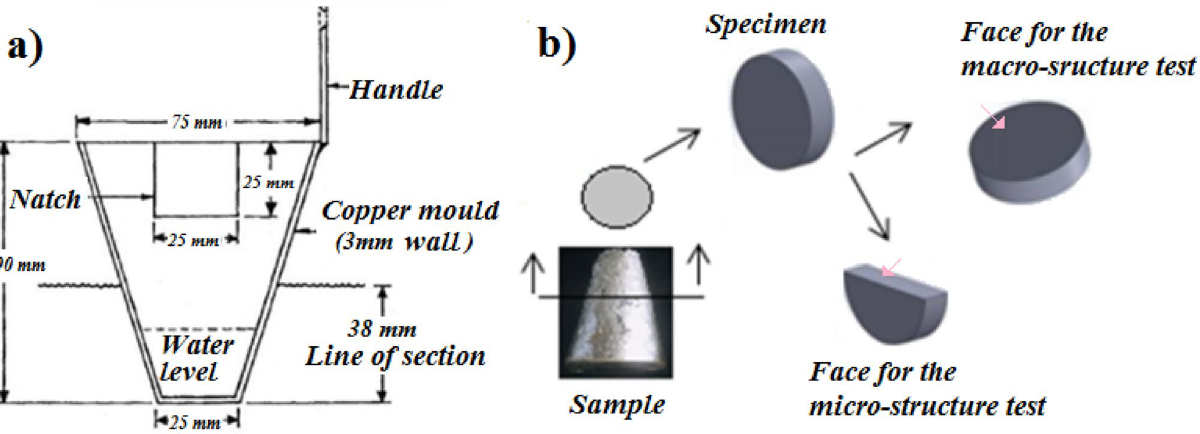
Figure 1. Illustrative sketch. ( a ) Mould ladle. ( b ) Cut of the